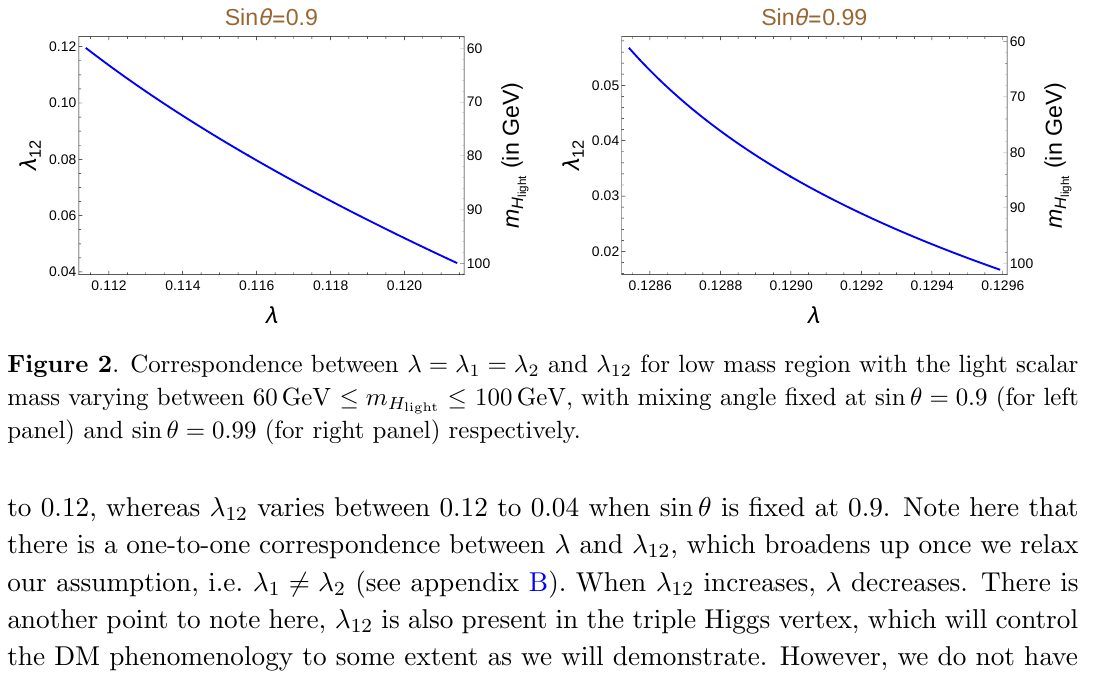
Sin θ = 0.9 Sin θ = 0.99